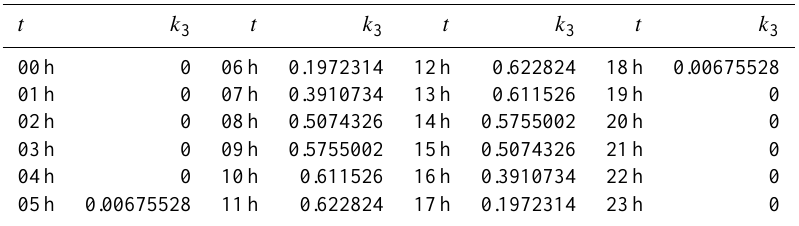
Table B1. Hourly values of k 3 in min − 1